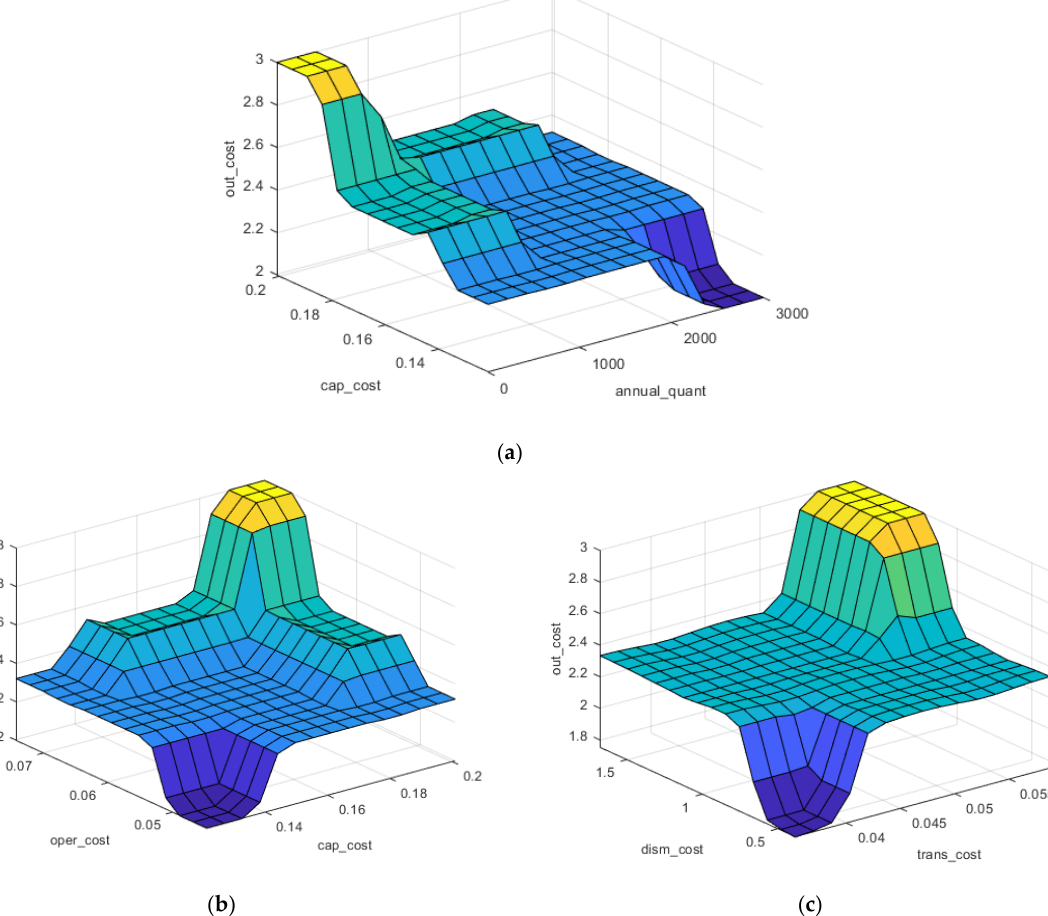
Figure 8. ( a ) Output cost levels related to the annual quantity and capital cost, ( b ) Output cost levels related to operational and capital cost, ( c ) Output cost levels related to transportation and dismantling cost. Figure 8b represents the impact of operational cost and capital cost fluctuation on the output cost. Capital and operational cost both have significant influence on the output cost; however, coinciding ranges of two input parameters result in extremum cost levels (yellow and dark blue colours on the plot). Nevertheless, it is equally important to mini- mize capital investments at the initial planning phases as well as operational cost in order to have the lowest possible output cost for recycled products. Figure 8c shows the simul- taneous effect of dismantling and transportation cost on output recycling cost. Not sur- prisingly, the same trend is noticeable: the extremums of low and high output cost are achievable only when operational and capital cost ranges coincide, e.g., output cost reach their lower range only when both parameters are at their lower ranges. The same charts with different inputs can be constructed by the system to determine the output cost of recycling at different levels of inputs or for other inference engines, i.e., transportation cost, dismantling cost. For instance, Figure 9 represents the relation of dis- tance and weight of transported waste to the transportation cost. The further the distance between CFRP waste and recycling plant, the higher transportation coefficient will be ap- plied for cost estimation which is illustrated by a yellow slope. For smaller weights up to one ton, the transportation coefficient shows low values, whereas larger weights leads to remarkably expensive transportation cost. Figure 9. Transportation cost levels related to distance and weight.